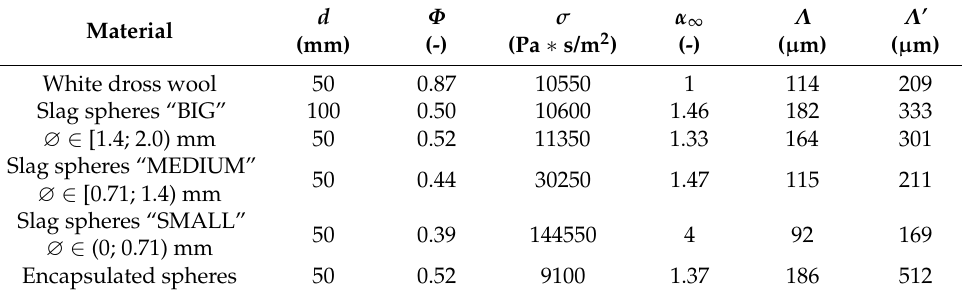
Table 4. Inversely determined non-acoustic